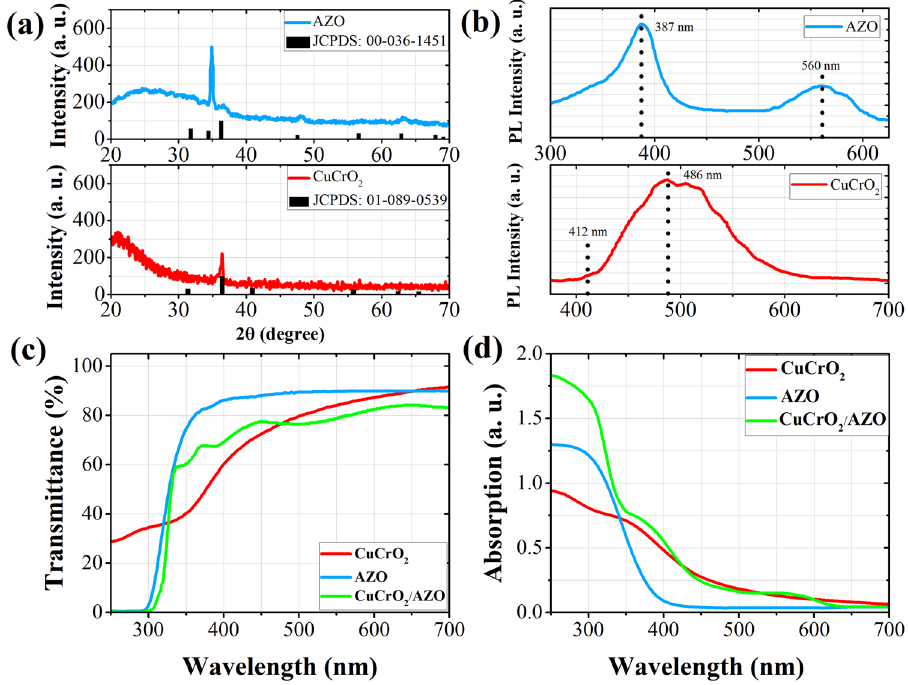
Figure 1. ( a ) Grazing XRD patterns of the prepared co-doped CuCrO 2 thin film after the post-deposition annealing and AZO thin film without post-deposition annealing, deposited on quartz substrate along with the corresponding JCPD references. ( b ) PL spectra of the AZO and co-doped CuCrO 2 thin films. ( c ) Transmittance and ( d ) absorption spectra of the prepared layers and the fabricated device acquired with UV–vis